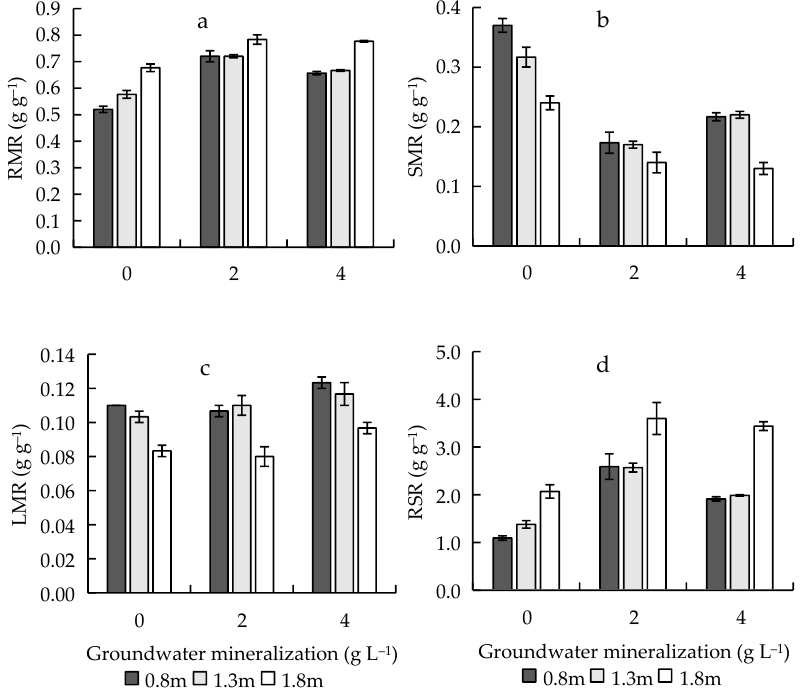
Figure 5. Effects of groundwater mineralization and groundwater depth on biomass allocation characteristics of R. pseudoacacia . ( a ) Root mass ratio; ( b ) stem mass ratio; ( c ) leaf mass ratio; ( d ) root– shoot ratio. Error bars indicate standard errors (SEs) of the mean.